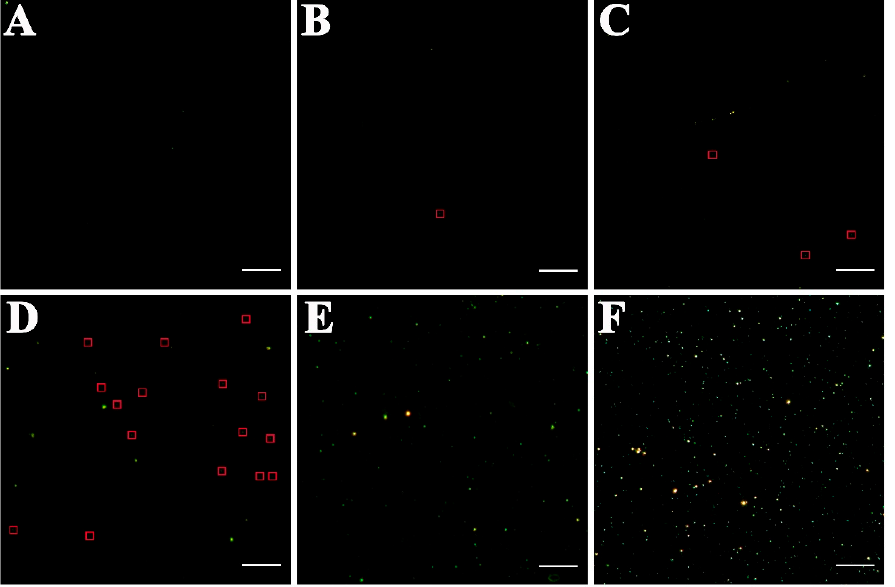
Figure 7. GNR probe-assisted DFM counting of PEDV samples. ( A ) Dark field image of sample without PEDV. ( B ) Dark field image of sample with PEDV of 3.07 × 10 1 copies/ μ L. ( C ) Dark field image of sample with PEDV of 1.53 × 10 2 copies/ μ L. ( D ) Dark field image of sample with PEDV of 7.67 × 10 2 copies/ μ L. The red squares are the green halos generated by a GNR recognized by count- ing software in B-D. ( E ) Dark field image of sample with PEDV of 3.83 × 10 3 copies/ μ L. ( F ) Dark field image of sample with PEDV of 1.92 × 10 4 copies/ μ L. ( G ) Calibration curves of DFM counting and qPCR. Each counting GNR number on the GNR probe-assisted counting method curve was ob- tained by multiplying the mean number of GNR particles from 20 DFM images of the corresponding PEDV sample on the chip by 400. The calibration curve of qPCR was plotted by the quantitative value (theoretical concentration) of RNA extracted from these PEDV samples versus the measured concentration values by the standard curve of the copy number corresponding to the concentration of the standard plasmid-CV777 (a specific gene fragment of PEDV). The pentagram is the intersec- tion of the calibration curve with three times signal-to-noise ratio. Scale bar: 20 μ m. 3.6. GNR Probe-Assisted DFM Counting of PEDV in Simulated Real Samples Simulated samples containing different concentrations of PEDV in the complex bio- logical matrix were prepared to validate our GNR probe-assisted DFM counting strategy. Various concentrations of PEDV used in the dark field counting method were also